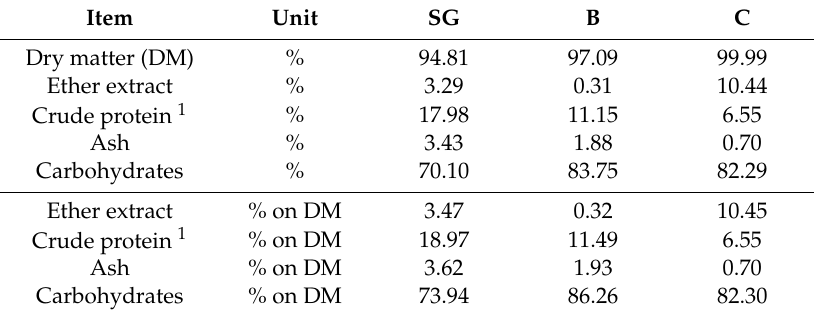
Table 1. Proximate composition of brewery spent grains (SG), bread (B) and cookies (C). Item Unit